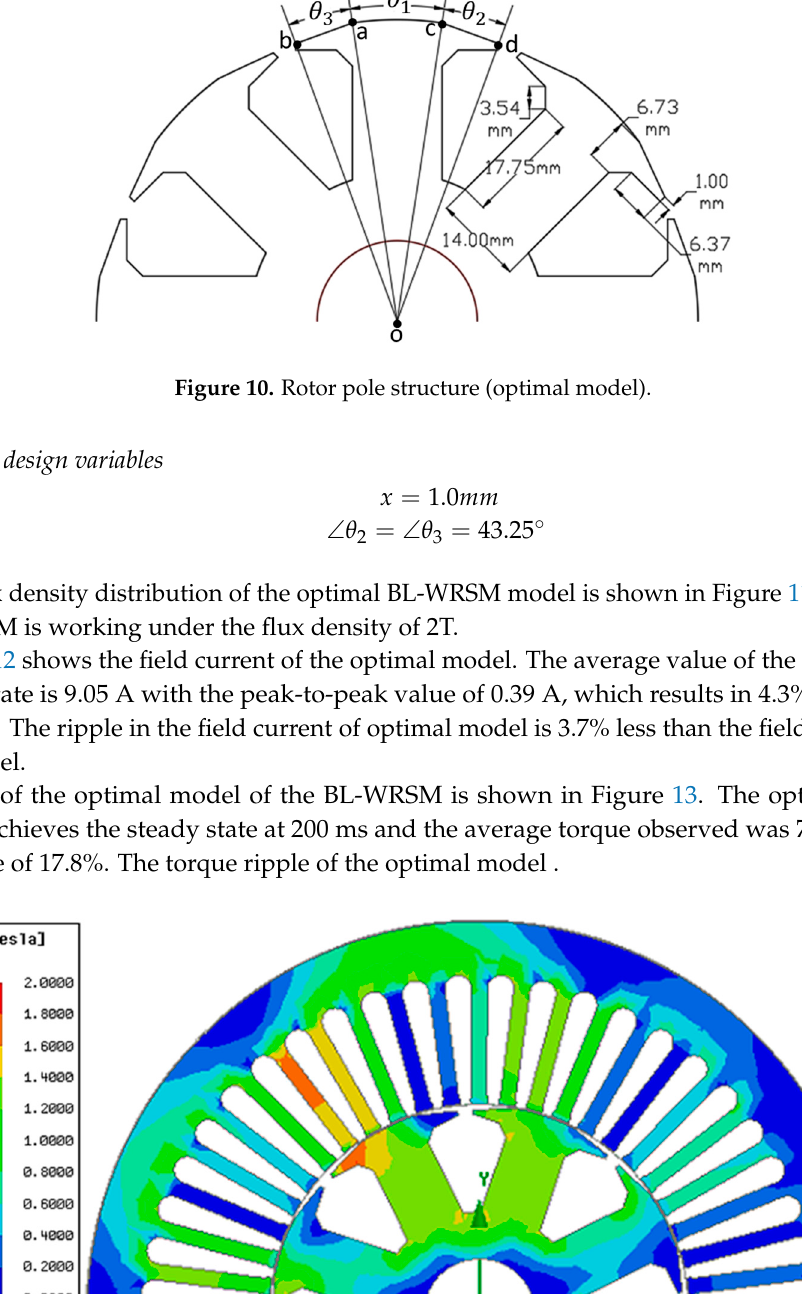
Figure 9. Optimal design process.